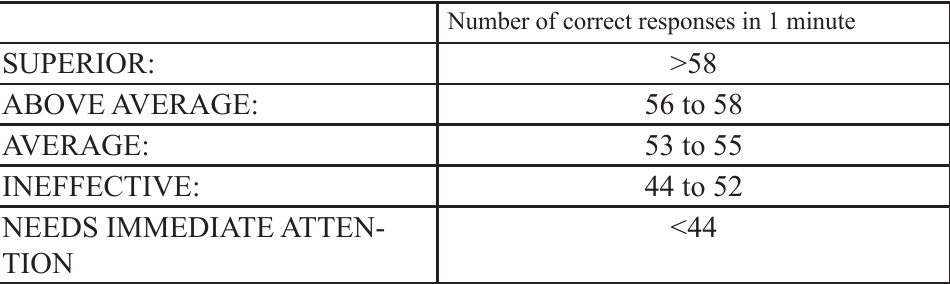
Table 8: The norms obtained for Central - Peripheral Awareness with the use of the Acuvision 1000 Number of correct responses in 1 minute